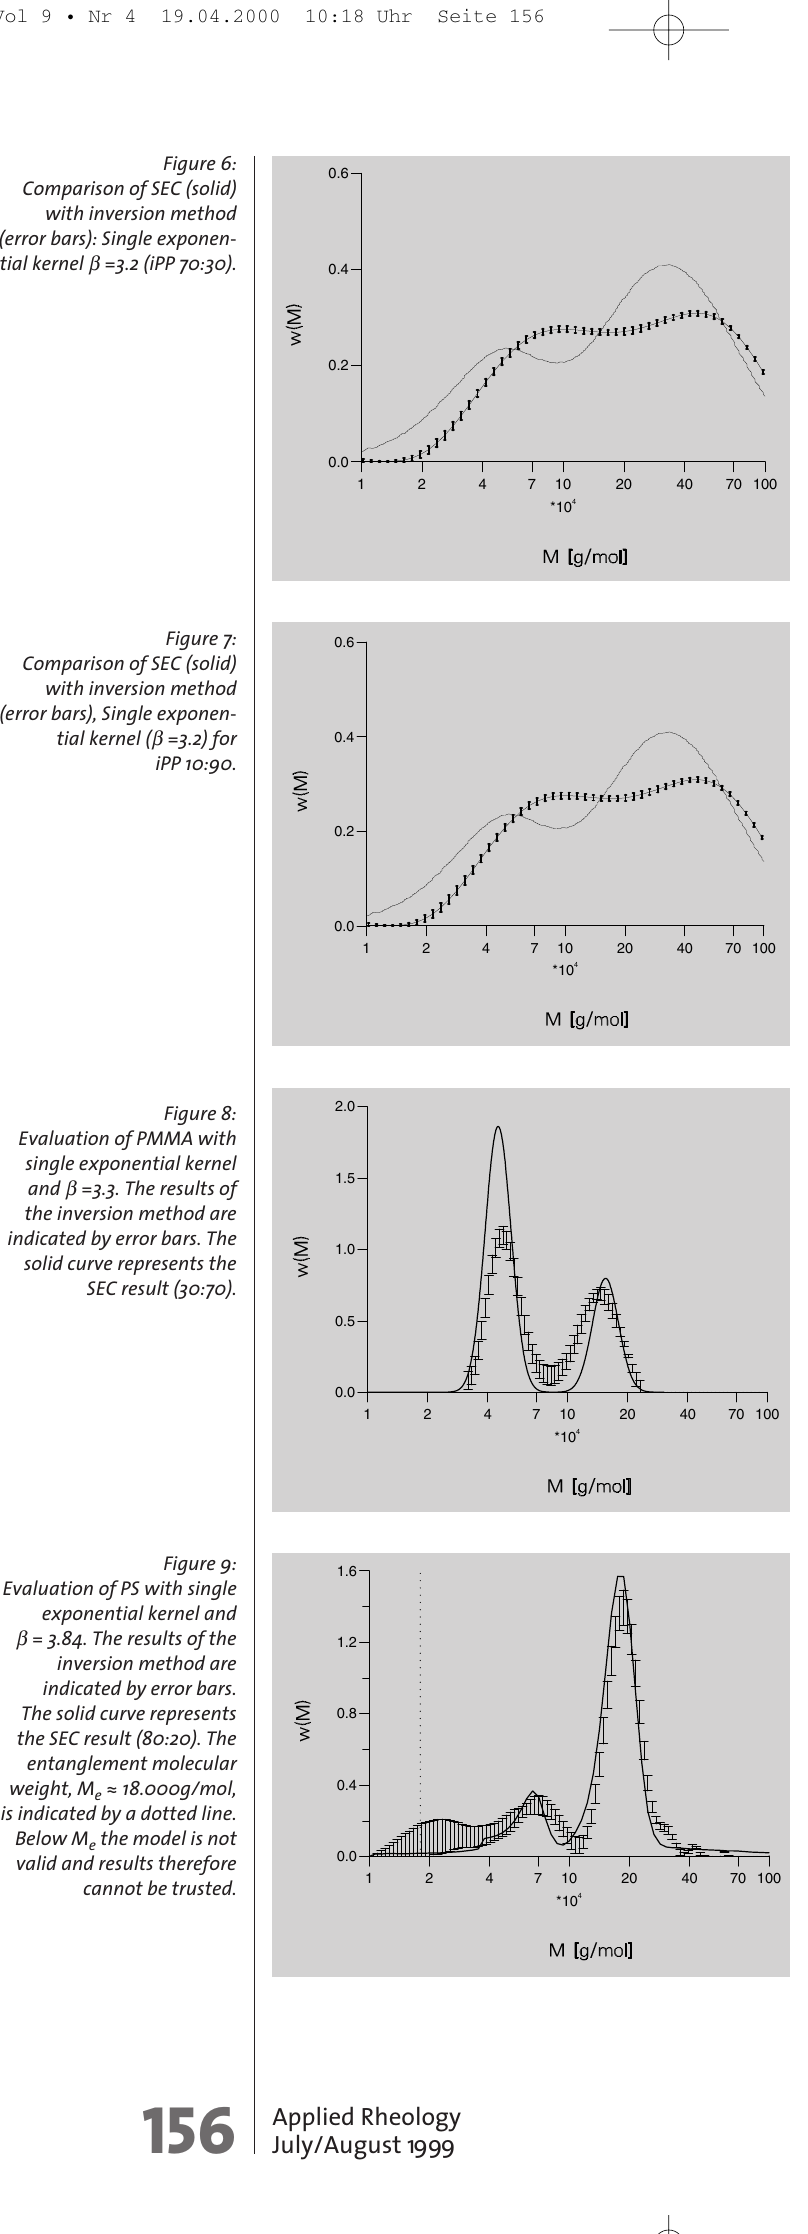
Figure 6: Comparison of SEC (solid) with inversion method (error bars): Single exponen- tial kernel β =3.2 (iPP 70:30).